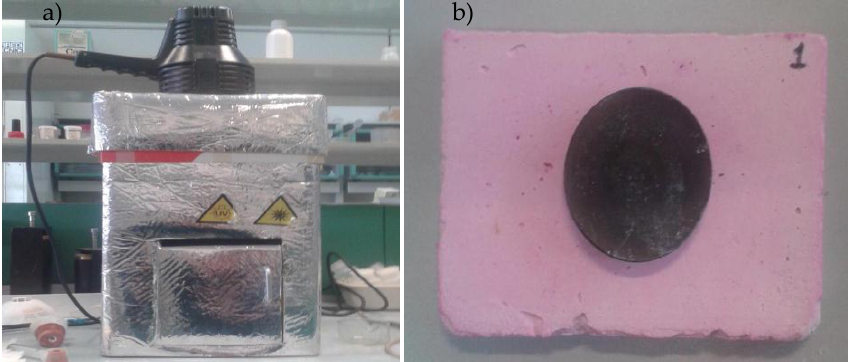
Figure 2. ( a ) Lamp Box UV 100 W − λ = 365 nm; ( b ) Specimen brushed with a solution of Rodamine partially shielded.